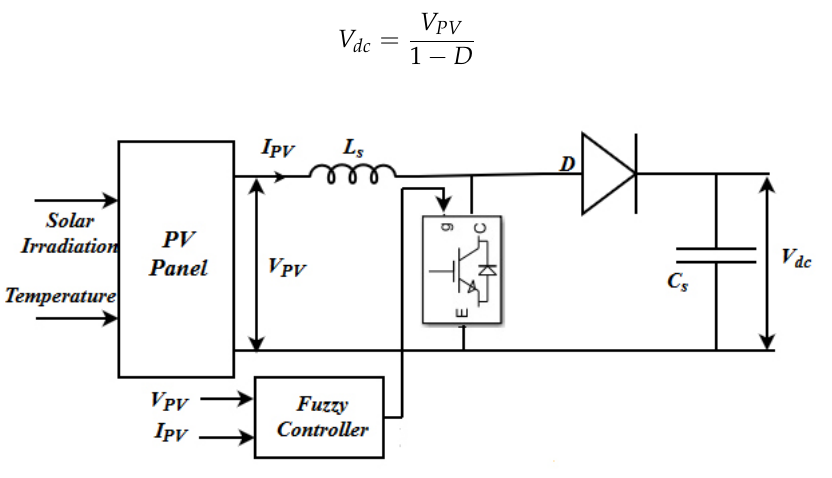
Figure 3. DC-DC Converter for solar cell.